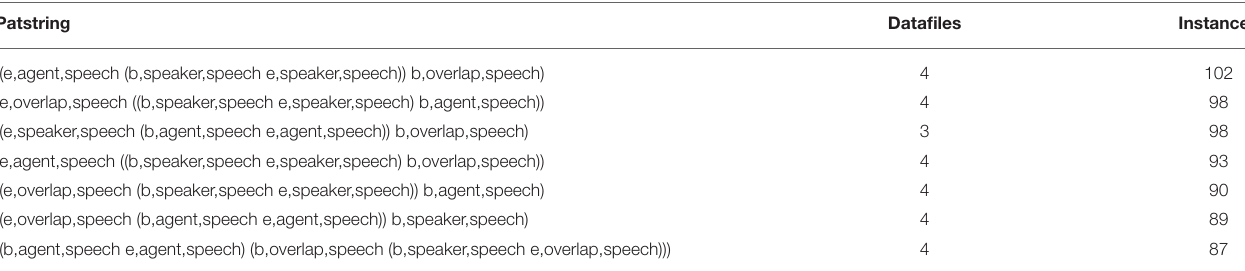
TABLE 2 | Resulting table of the first query containing T-patterns (only the relevant attributes are preserved here). Patstring Datafiles